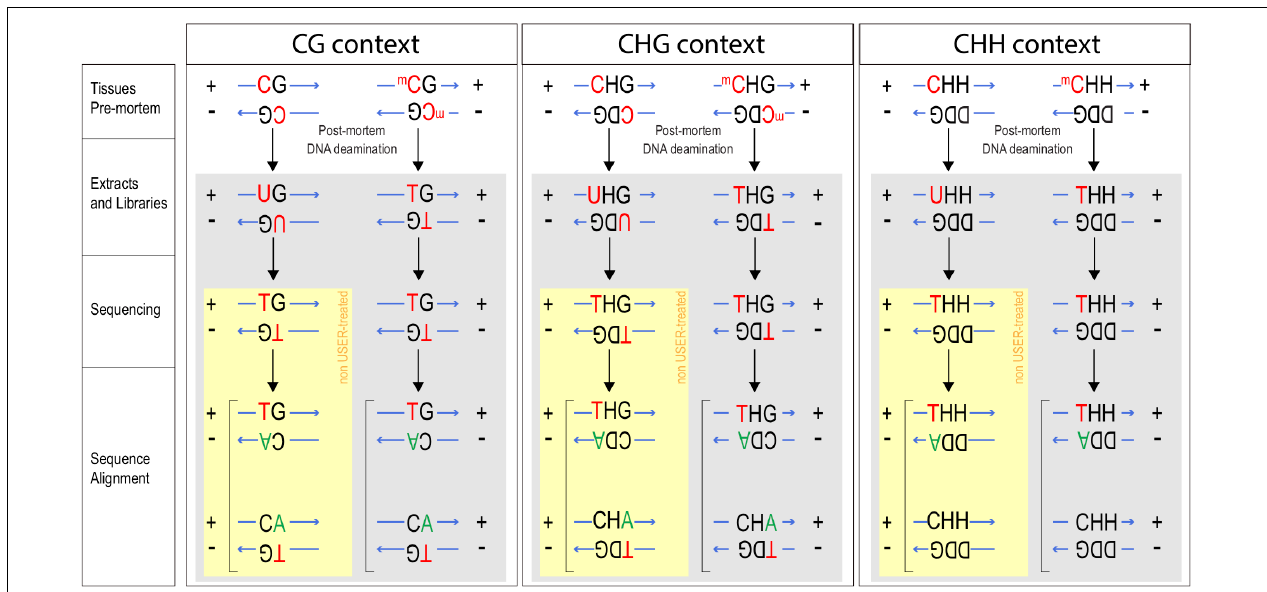
FIGURE 1 | Tracking methylation in CG, CHG, and CHH contexts. After death, unmethylated Cytosines (C) become deaminated into Uracil (U), whereas methylated Cytosines ( m C) become Thymines (T). In the absence of USER treatment, Us enter into library preparation and sequencing. C → T mis-incorporation will be observed for deaminated residues from methylated (C → T) and unmethylated Cytosine residues (C → U, sequenced as T; yellow box). If USER treatment is applied, U is excised prior to sequencing and C → T conversions can be used as a proxy for those Cs that were methylated pre-mortem. Base mis-incorporations highlighted in red and green. Ms ratios were calculated for raw extracts and USER treated extracts for the three plant methylation contexts CG, CHG, and CHH (where H refers to A, C, or T and D to T, G, or